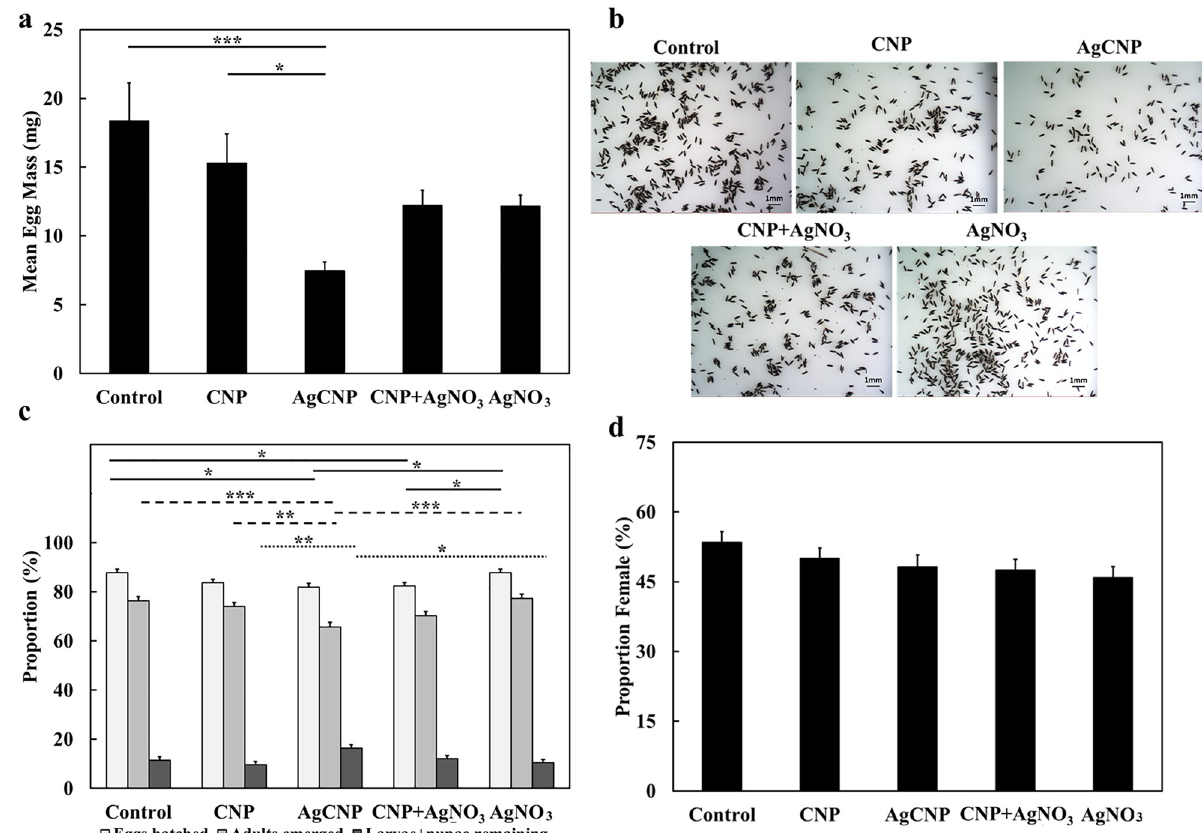
Fig 10. Effects of nanoparticles on fecundity of Ae . eagypti female mosquitoes when administered via a blood meal (bulk experiment). Nanoparticles were fed to Ae . aegypti females in bulk via a blood meal and subsequent fecundity studies were performed. ( a ) Mean egg masses produced from female mosquitoes fed nanoceria. Females in the AgCNP-treated group produced a significantly lower mean mass of eggs compared to the control and CNP-treatment groups (p-values < 0.001 and 0.05, respectively). ( b) Representative images of eggs oviposited by control and nanoceria- treated females; morphology of eggs in all the groups appears similar. ( c ) Mean proportions of eggs hatched, adults emerged and larvae + pupae remaining. The mean proportions of eggs hatched in the AgCNP and CNP + AgNO 3 groups were significantly lower than that of the control and AgNO 3 groups (p-values < 0.05). The mean proportion of adults emerged in the AgCNP group was significantly lower compared to those of the control, AgNO 3 , and CNP treatment groups (p-values < 0.001, 0.001 and 0.01, respectively). The mean proportion of larvae + pupae remaining in the AgCNP group was significantly lower than those of CNP and AgNO 3 groups (p-values < 0.01 and 0.05, respectively). ( d ) Mean proportion of females (sex ratio) observed in the adults emerged in ( c ); the mean sex ratios of all groups were not significantly different form each other. � : p-value < 0.05, �� : p-value < 0.01, ��� : p-value < 0.001. Solid lines in ( a ) indicate significantly different comparisons between the mean egg masses in different treatment groups, while in ( c ), the solid lines indicate significantly different comparisons between mean proportions of eggs hatched in different treatment groups. Dashed lines indicate significantly different comparisons between the mean proportions of adults emerged in different treatment groups. Dotted lines indicate significantly different comparisons between the mean proportions of larvae + pupae remaining in different treatment groups. Error bars in ( a ) = SEM, Error bars in ( c ) and ( d ) = SEP. All Experiments were repeated three (3) times with 1–3 cups of 50 mosquitoes each ( a ) or 100 eggs each ( c ) yielding 6–7 cups in total for each experimental